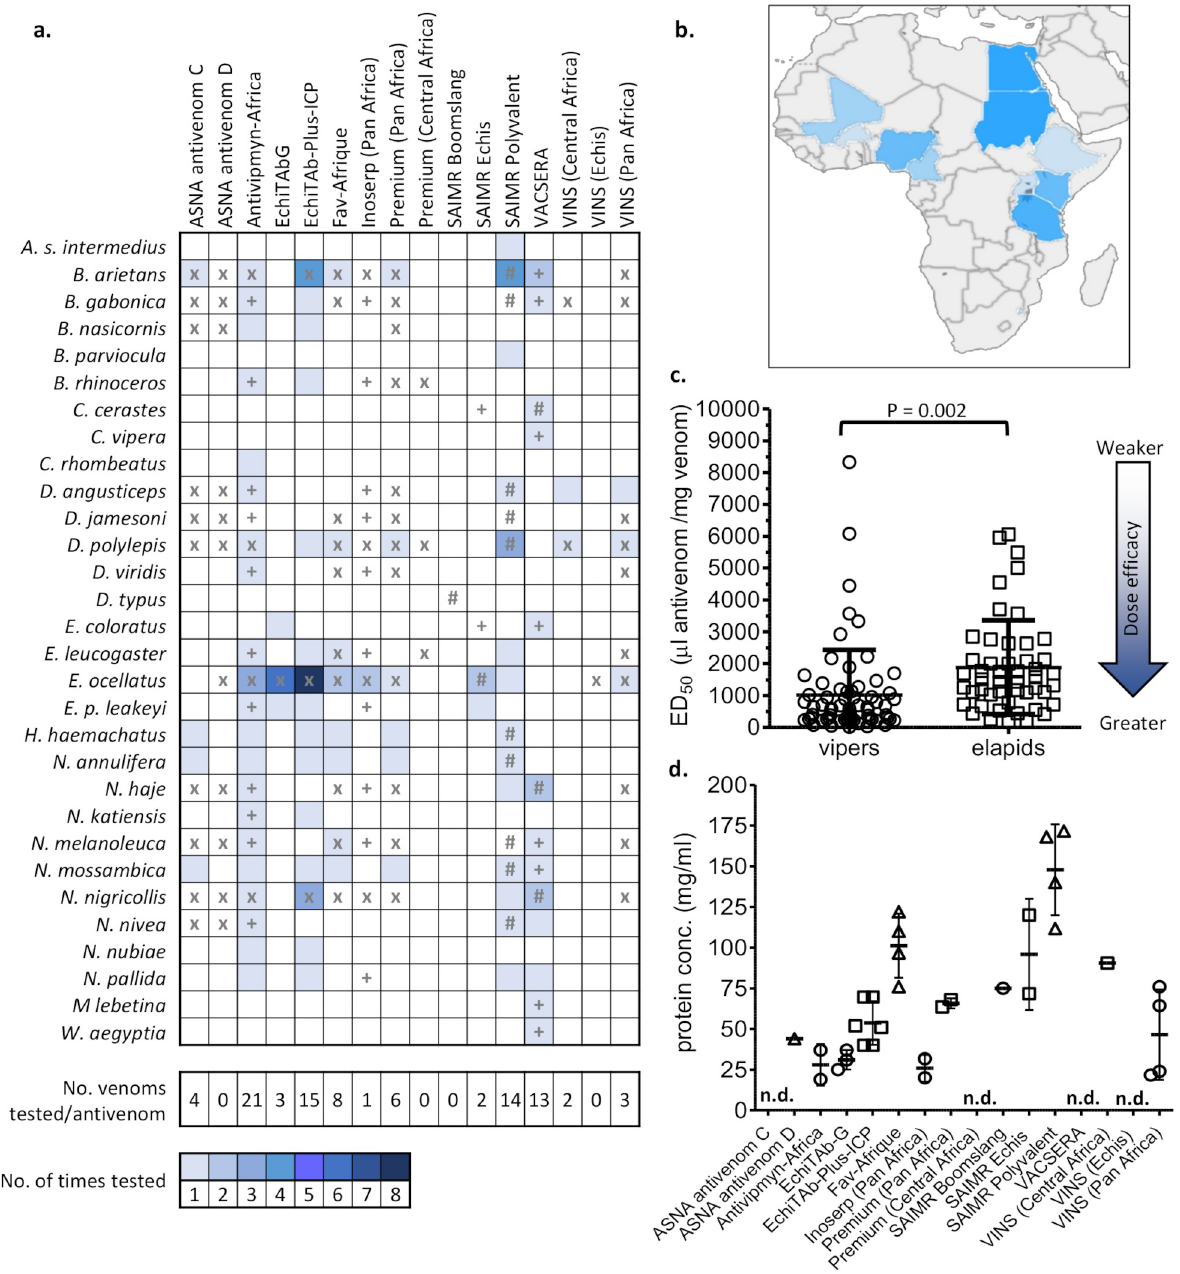
Fig 1. Summary of breadth and frequency of publicly available preclinical testing data of available African antivenoms vs. medically important snakes of the region. a) The heat map represents the number of times each antivenom has been tested against a venom. x = antivenom manufacturer makes specific claims of neutralisation against this venom. + = antivenom manufacturer makes specific claims of para-specific neutralisation against this venom (i.e. venom not used as an immunogen). # = manufacturer has claimed this venom is used for immunisation during antivenom manufacture. Antivenom names as in Table 1. b) The geographical origin of the snake venoms used in prior preclinical studies of African antivenom efficacy. The darker the blue colour, the more venoms that were investigated from that country. Countries without colour did not have any venoms represented in the preclinical testing in the identified studies. c) The preclinical efficacy of African antivenoms against venoms from vipers and elapids (see S1 Table for species classification, individual values and references). ED 50 values represented as dose of antivenom, in μ l, which prevents lethality in 50% of test mice per mg of venom ( μ l/mg). Significance (P) determined using an unpaired t test with Welch’s correction. d) Total protein content of African antivenoms in this study. Bold bar represents the mean, whiskers represent standard deviation of the mean. Values and references supporting this data are available in S2 Table. Bars represent standard deviation of the mean, and n.d. indicates not determined/available.